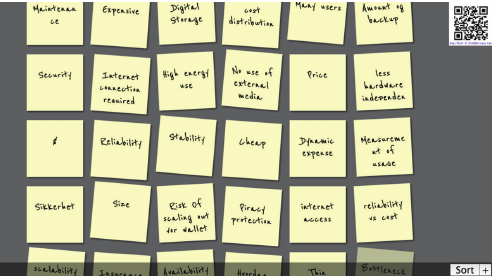
Figure 9: The results of the Post-It session in lecture two.